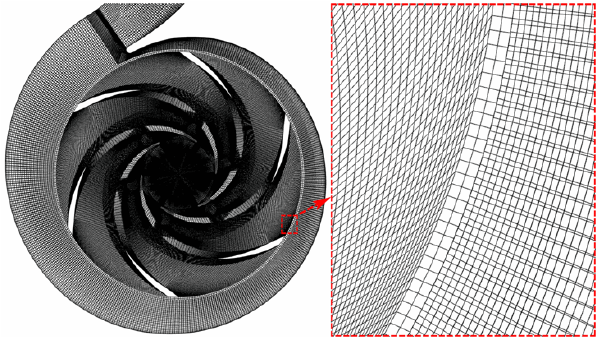
Figure 3. Hexahedral grids in the impeller’s computational domain ( left ), and a zoomed-in view of the area around the volute ( right ).